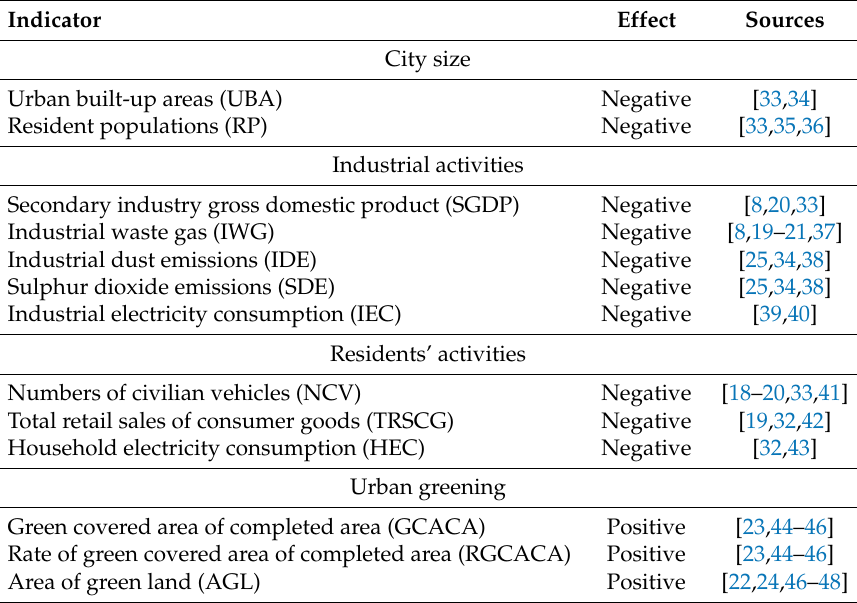
Table 1. Selected indicators and related